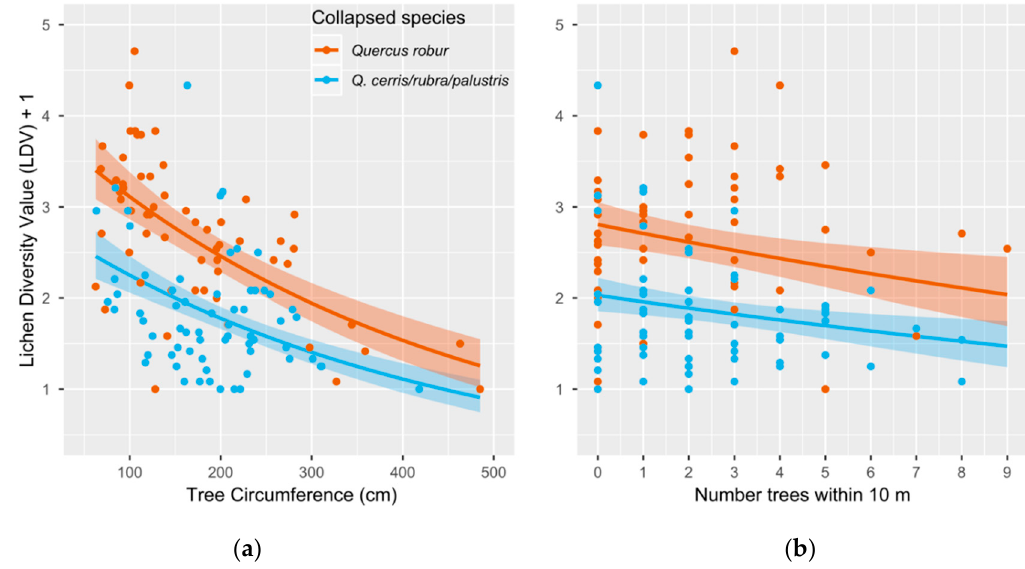
Figure 3. Scatterplots showing the relationship between epiphytic lichen diversity (LDV) and host Quercus circumference, number of trees within 10 metres and Quercus species. Quercus cerris, Q. rubra and Q. palustris were collapsed into one factor level (blue) due to a lack of significant difference between them. ( a ) Lichen diversity (LDV + 1) significantly decreased with increasing tree circumference; ( b ) LDV significantly decreased with increasing number of trees within 10 metres. Tree species significantly affects LDV with Q. robur (red) hosting higher lichen diversity than the collapsed group of Q. cerris, Q. rubra and Q. palustris (blue). No significant interaction is seen between tree circumference, number of trees within 10 m and tree species. Fitted regression lines and 95% confidence intervals (coloured boxes around regression lines) were predicted using the minimum adequate model shown in Table 1.